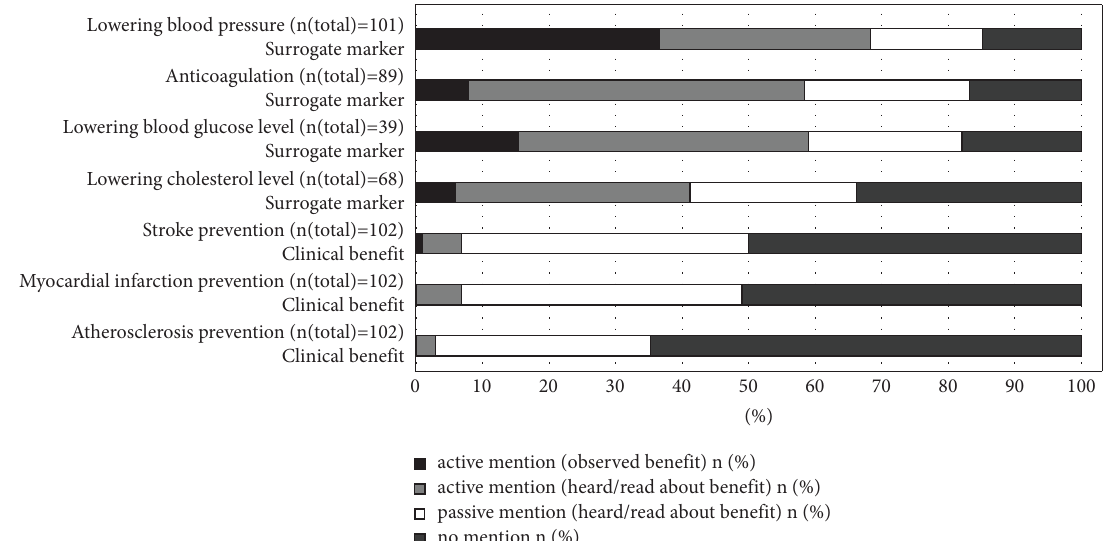
Figure 2: Patients’ association of predefned benefts with their therapy. n (total) refers to the respective patients with the corresponding cardiovascular medication. Patients mentioned benefts actively without any suggestion or subsequently passively based on a list of suggestions. Patients mentioned surrogate markers signifcantly more frequently than clinical benefts (actively and passively mentioned: p < 0 . 001; only actively mentioned: p < 0 . 001).